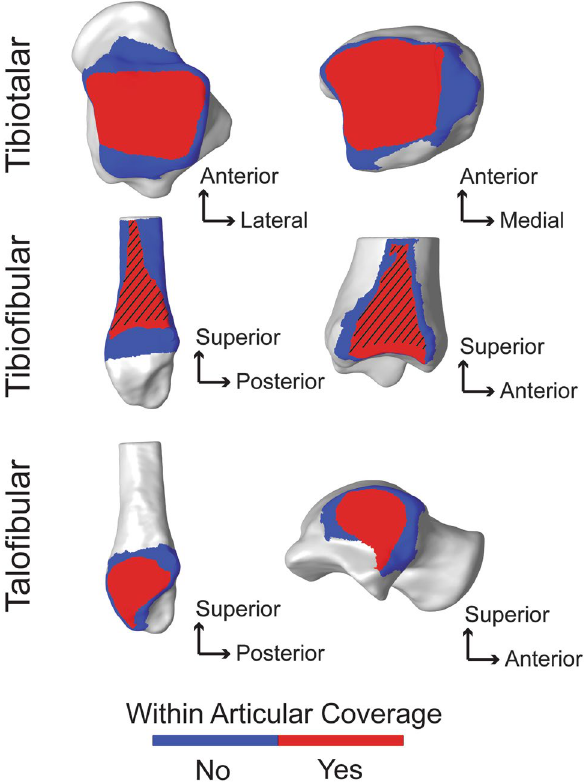
Figure 4. Coverage analysis showing regions of articular coverage for the tibiotalar, tibiofibular and talofibular joints. Regions within the articular coverage are shown in red. Regions in blue represent the initial region of selection based on the second principal curvature, with the rest of the bone shown in grey. Important to note, the articular coverage regions are defined mathematically as described in the methods and due to the imaging limitation of WBCT cannot be directly correlated with regions containing articular cartilage. However, the region for the tibiofibular relationship, shown with the black angled lines, represents the region of the distal tibiofibular syndesmosis anatomically known to contain the interosseous ligament throughout this generalized region. Distal to the dashed region, at the base of the syndesmosis, there is typically a small tibiofibular contact zone 32 . But for the purpose of this analysis, the tibiofibular contact zone and syndesmosis regions were not separated mathematically within the articular coverage region identified.